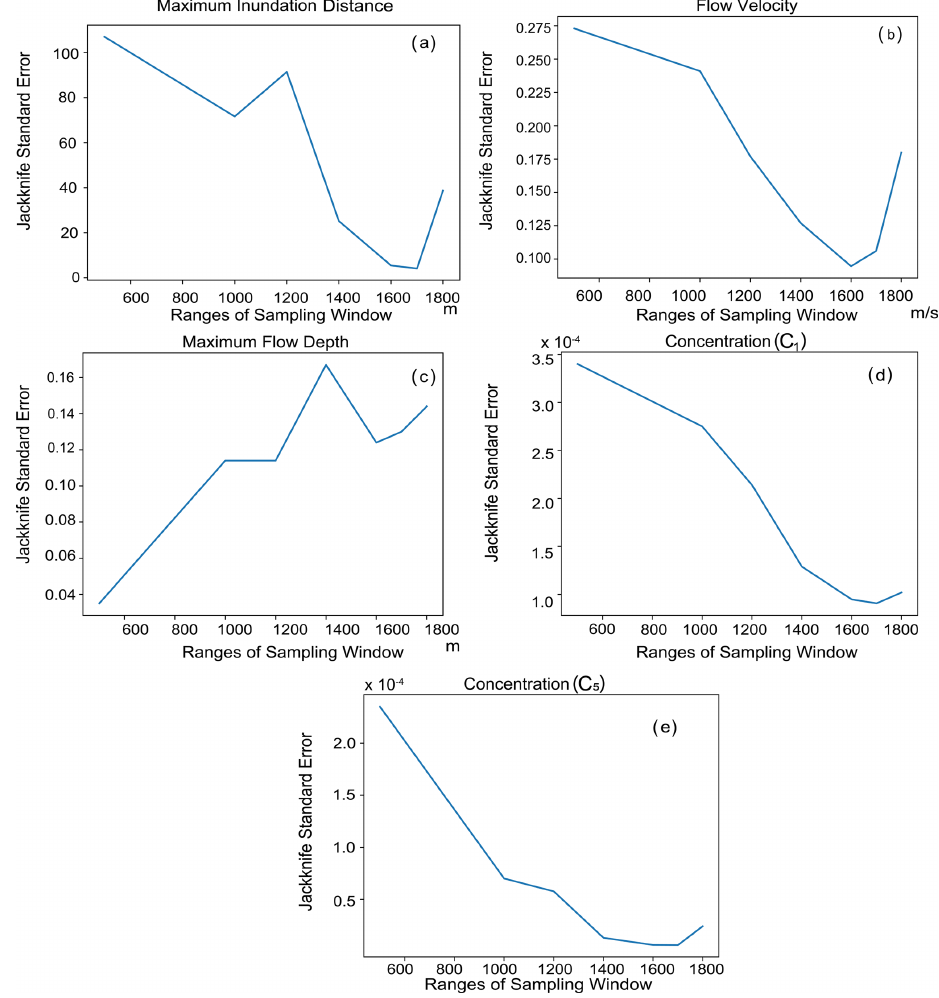
Figure 9. Propagation of jackknife standard errors with a different range of sampling window